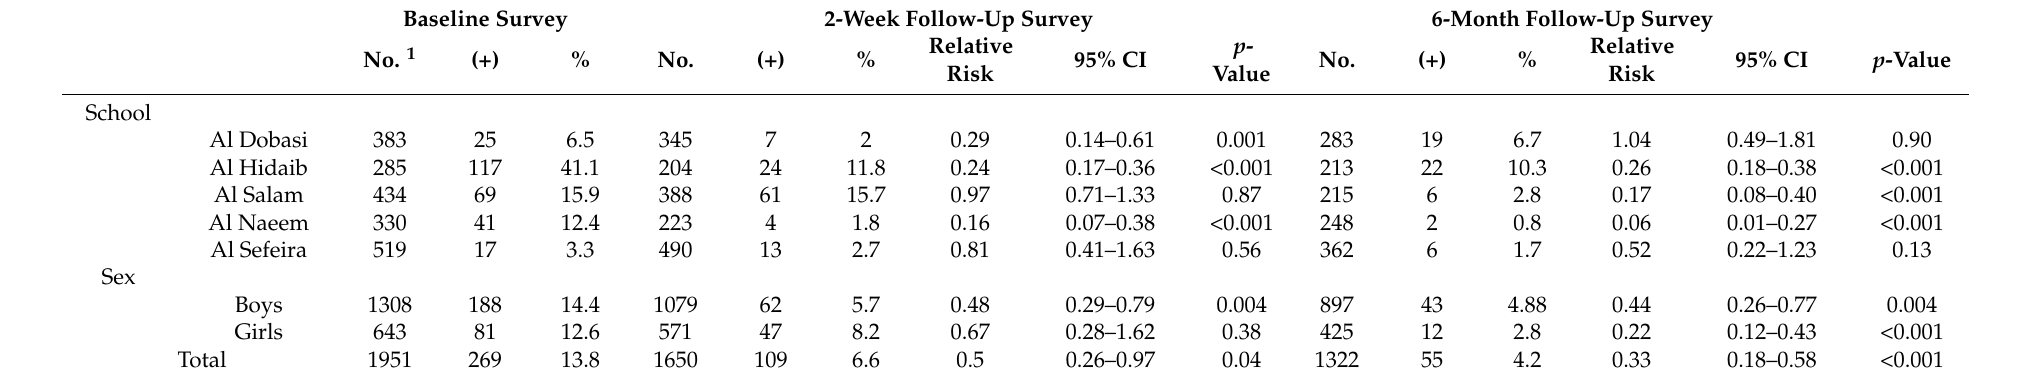
Table 2. The prevalence of S. haematobium at baseline, at 2 weeks, and at 6 months after mass drug administration.